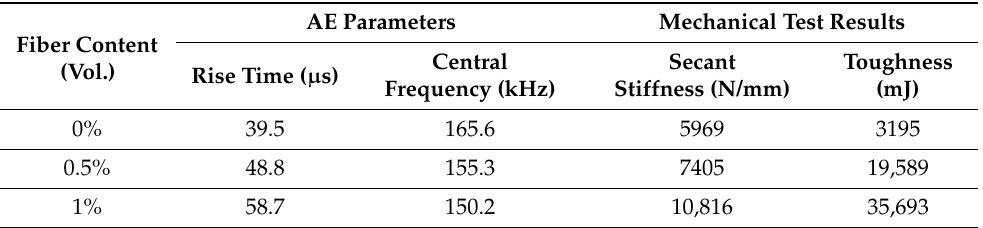
Table 1. Basic AE parameters and mechanical test results for different fiber contents after the three- point bending test.